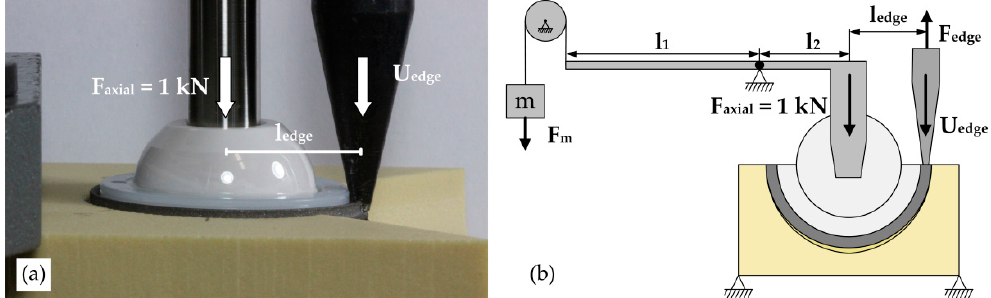
Figure 3. Test Method 2. ( a ) Experimental test setup for the displacement-controlled edge load test. ( b ) A schematic view of the edge-load test. By means of a lever construction (l 1 and l 2 ) in combination with a deflection roller, the weight (F m ) of the mass (m) introduced an axial force F axial = 1 kN into the liner of the acetabular cup. The tangential displacement of the cup edge (U edge ) to the implant–block interface counteracted the resistance moment (M edge ). The moment (M edge ) resulted from the distance between the axial force (F axial ) and the reaction force (F edge ), which counteracted the displacement of the cup edge.